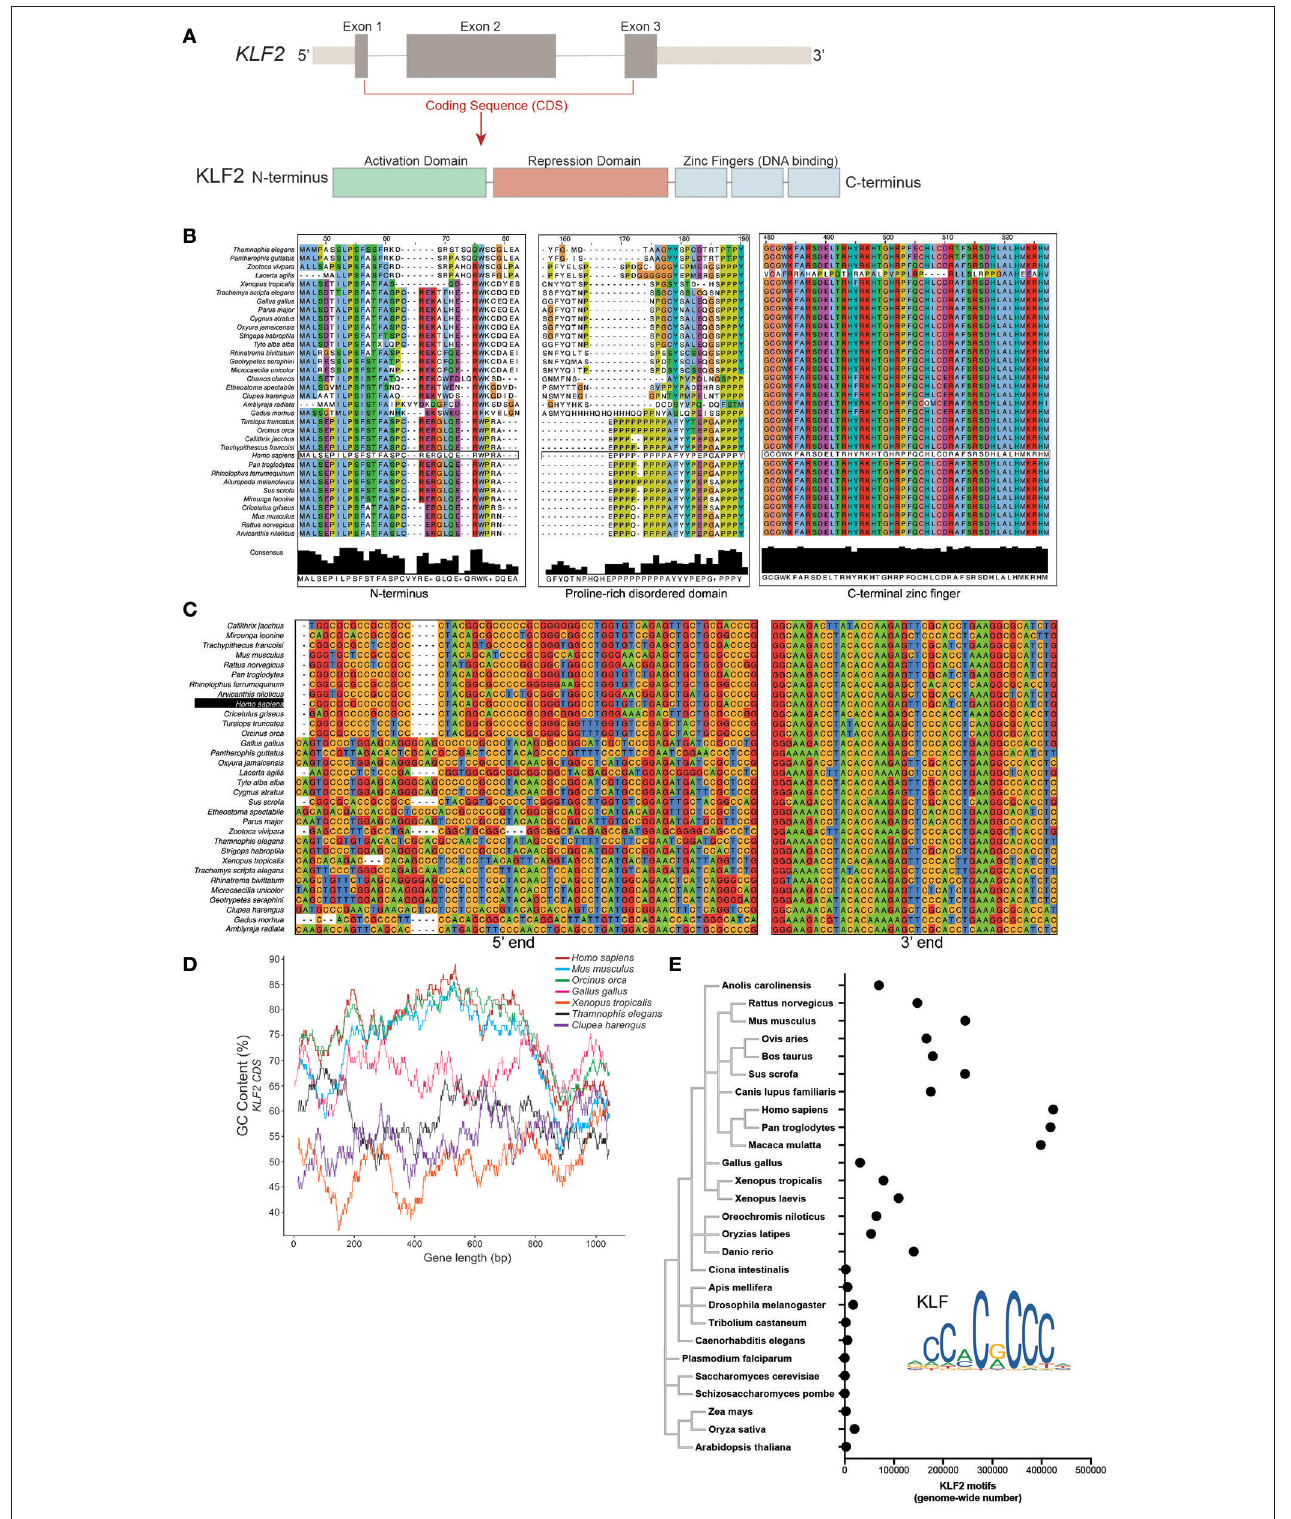
FIGURE 1 | (A) Schematic representation of the KLF2 gene and protein delineating exons and functional domains. (B) Clustal Omega amino acid alignment for KLF2 orthologs from 34 species across multiple vertebrate classes. (C) Clustal Omega nucleotide alignment for KLF2 orthologs. (D) GC content plot for representative species from different classes. GC% was calculated in a 100 bp window. (E) Position weight matrix analysis of KLF2 binding motif occurance in various species. Points represent number of motifs found with a significance enrichment of p < 0.00005.